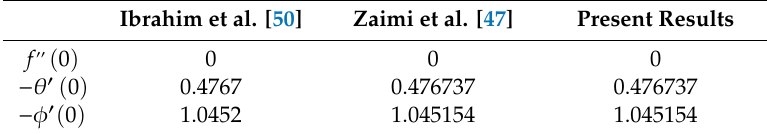
Table 1. Comparison of f (cid:48)(cid:48) ( 0 ) , − θ (cid:48) ( 0 ) and − φ (cid:48) ( 0 ) when ε 1 = 1, Pe = 1, Le = 2, Sc = 1, A = 0, Nt = Nb = 0.5, and Pr = 1 in Equations (8)–(12) and setting M = 0 and A = 1 in Equations (18) and (21) of the paper by Ibrahim et al.